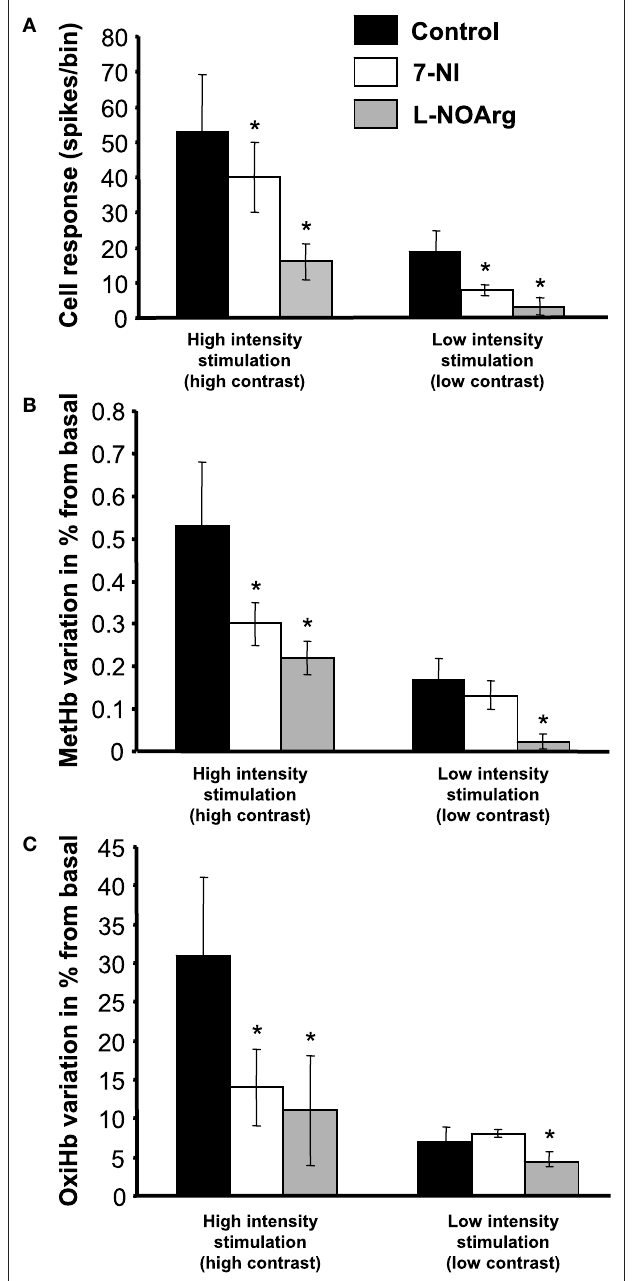
FIGURE 5 | Effects of NOS blockade on neuronal and metabolic signals. Effects obtained after 7-NI (specifi c nNOS blocker) or L -NOArg (non specifi c NOS blocker) I.V. injections on neuronal responses (A) , MetHb (B) and OxyHb (C) for high (100%, bars on the left part of the fi gure) and low (10%) contrast stimulation (bars on the right part of the fi gure). *Represents signifi cant differences ( t -test; p < 0.05) when compared with the control condition.